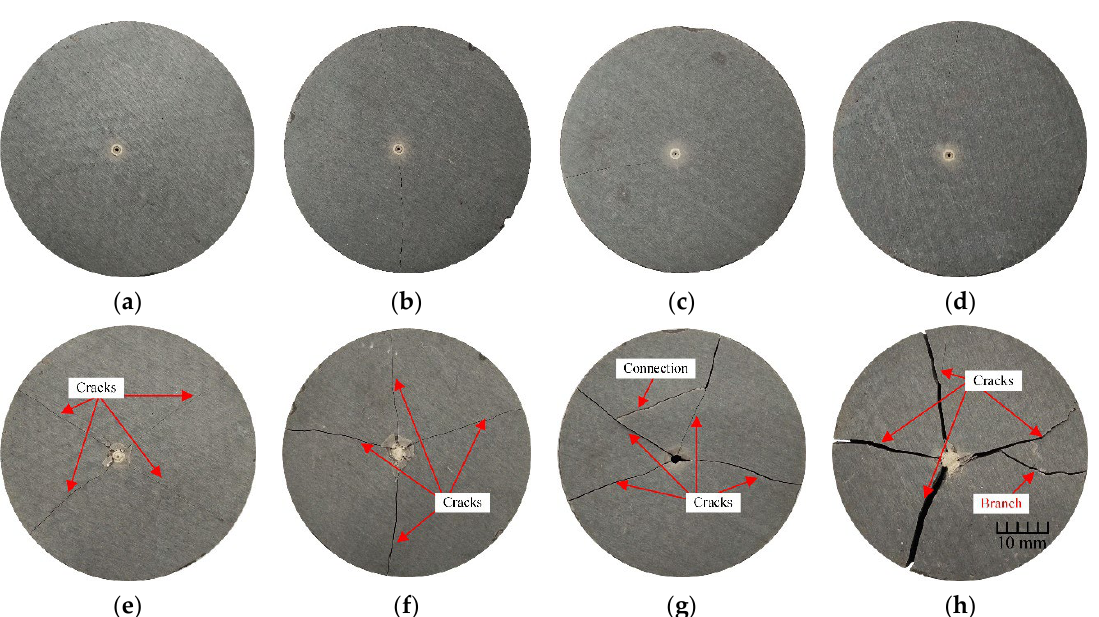
Figure 12. Surface morphology of soaked sample after laser irradiation at a power of 135 W: ( a ) 90 s; ( b ) 120 s; ( c ) 150 s; ( d ) 180 s; ( e ) 90 s after one month; ( f ) 120 s after one month; ( g ) 150 s after one month; and ( h ) 180 s after one month.